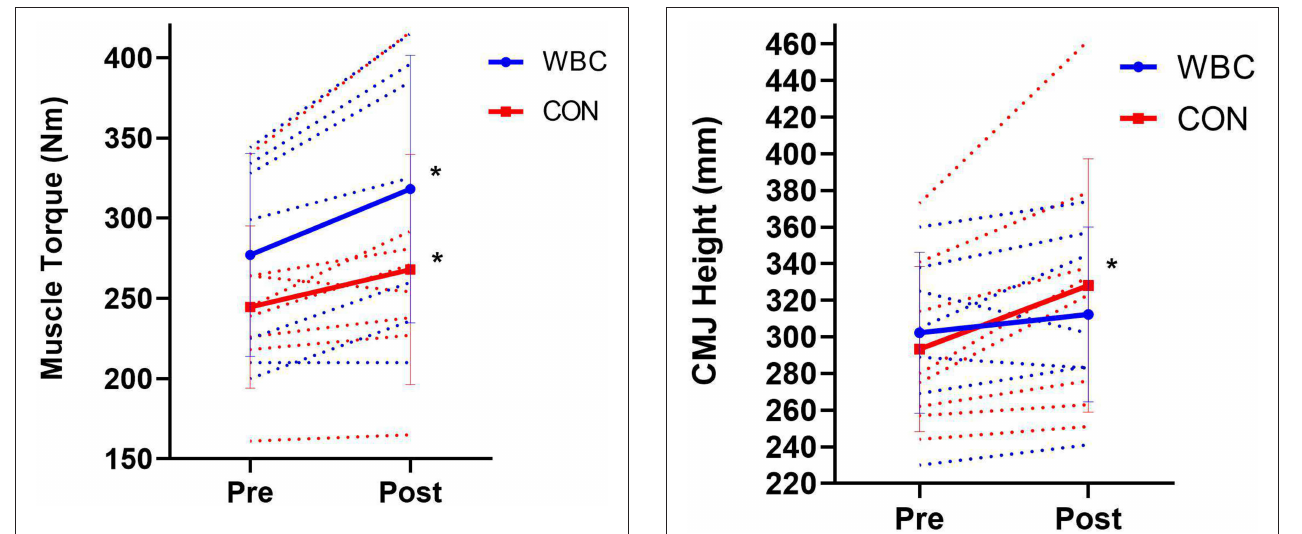
FIGURE 4 | Leg muscle torques for WBC ( n = 7) and CON ( n = 9) before and after 6 week training programme. * p ≤ 0.05 for increase in both groups. Solid lines present means ± standard deviations. Dotted lines present individual participant responses. N = 16.